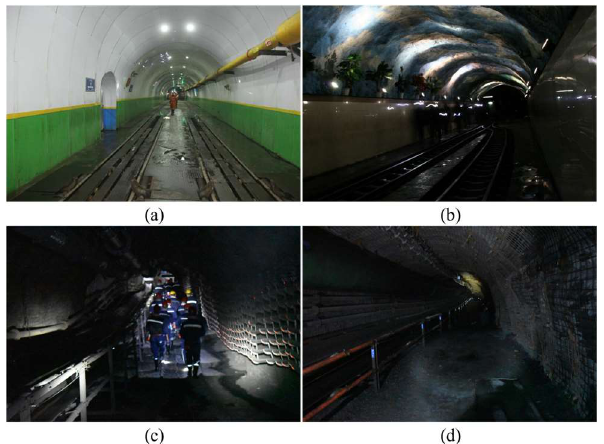
Figure 1. Typical environments in underground coal mine. ( a ) is a main roadway of a coal mine. ( b ) is the shaft bottom of coal mine. ( c ) is general roadway in coal mine. ( d ) is a haulage roadway.